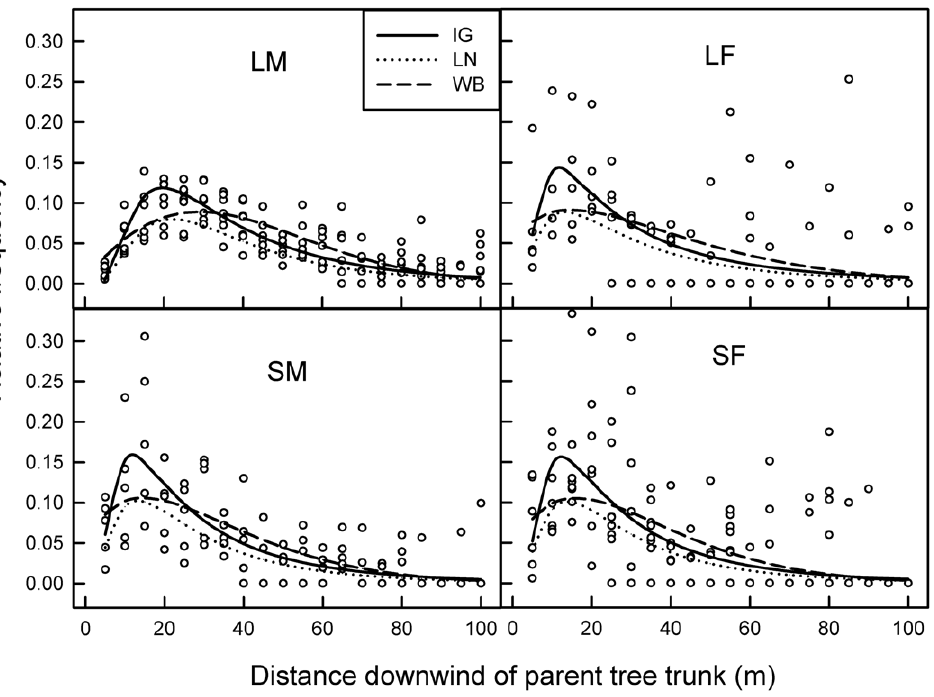
Figure 3. Dispersal of mahogany ( Swieteniamacrophylla ) seeds in two dimensions downwind of 25 parent trees in Para´, Brazil. Relative frequency of dispersal is the proportions of normalised seed counts downwind per tree for a given 5-m distance interval, generated from the original 1-m wide transects. The probability density function (pdf) of a given distance interval occurring was fitted to the normalised data using three equations: IG = inverse Gaussian (Wald); LN = lognormal; and WB = Weibull (see Table 1 ).